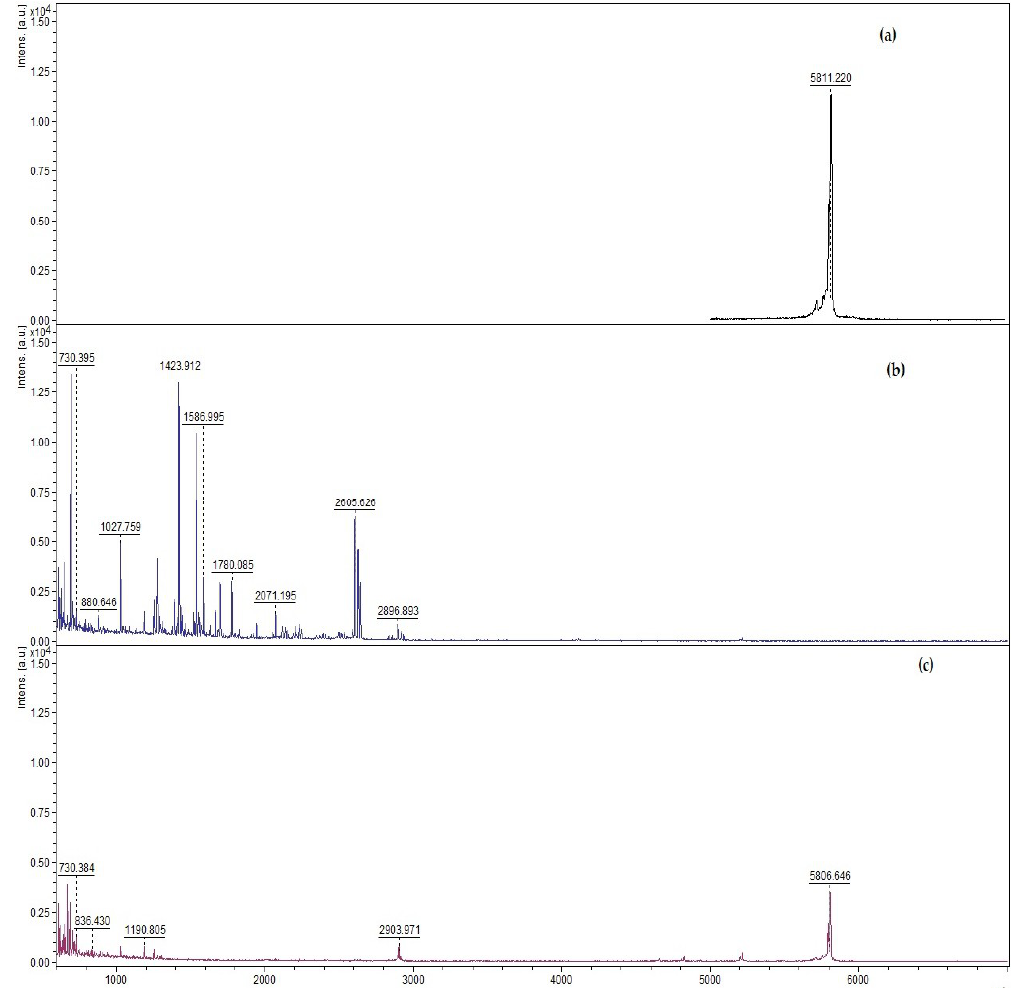
Figure 3. Qualitative study results obtained from MALDI-TOF spectrum, revealing the role of functional dispersion (insulin–PEGylated SWCNTS) to protect insulin from proteolytic enzyme pepsin: ( a ) pharmaceutical regular insulin; ( b ) pharmaceutical insulin incubated for 30 min with pepsin enzyme; and ( c ) functional dispersion of insulin PEGylated SWCNTs incubated with pepsin for 30 min.